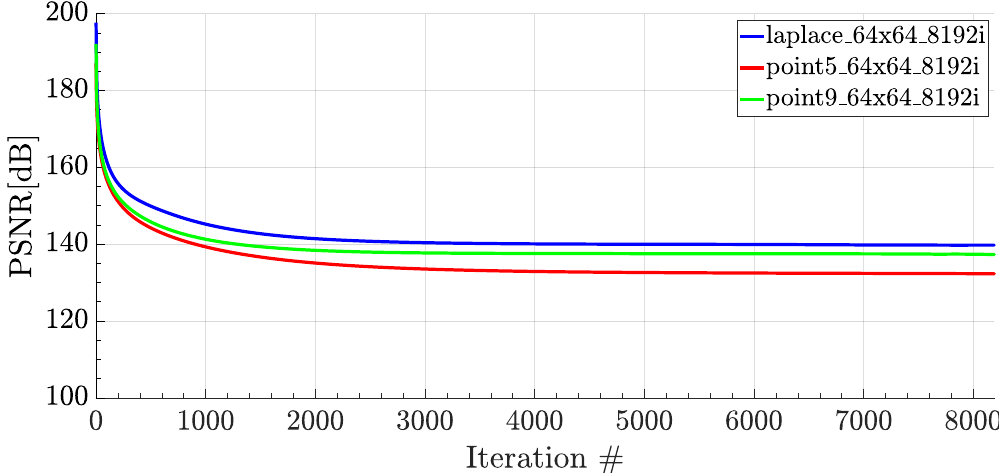
Figure 5. Peak signal-to-noise ratio (PSNR) with respect to the iteration number during various stencil operations on 64 × 64